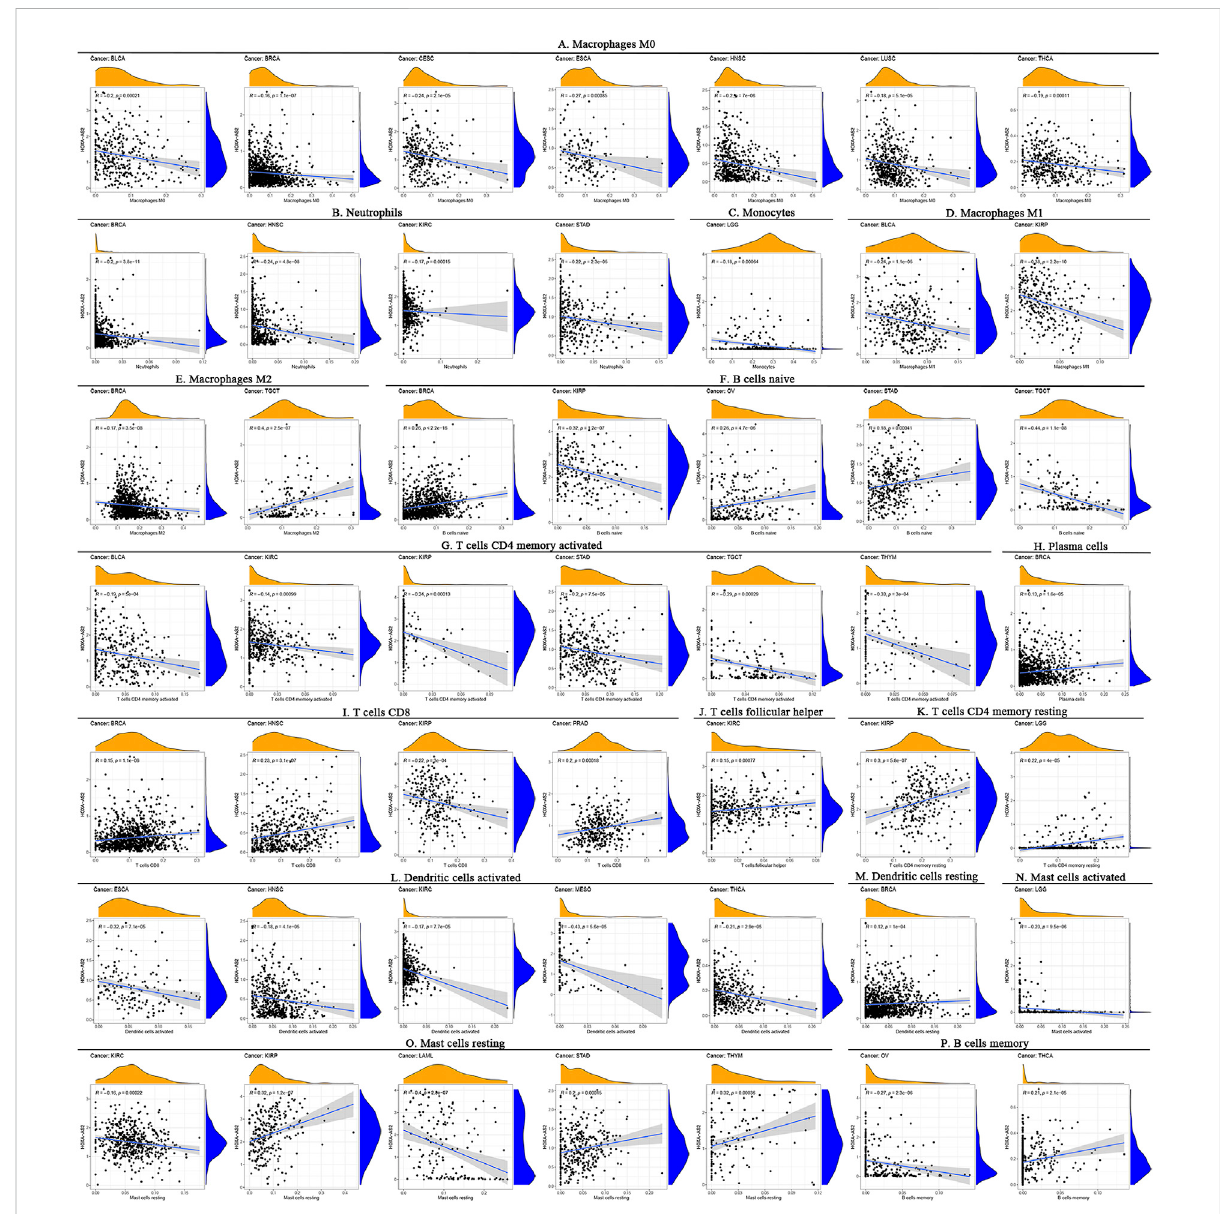
FIGURE 7 Correlation between HOXA-AS2 gene expression and the level of immune cell in fi ltration in pan-cancerous tissues. HOXA-AS2 expression signi fi cantly correlated with in fi ltrating levels of M0 macrophages in BLCA, BRCA, CESC, ESCA, NHSC, LUSC, and THCA (A) , neutrophils in BRCA, HNSC, KIRC, and STAD (B) , monocytes in LGG (C) , M1 macrophages in BLCA and KIRP (D) , M2 macrophages in BRCA and TGCT (E) , naive B cells in BRCA, KIRP, OV, STAD, and TGCT (F) , CD4 memory T cells in BLCA, KIRC, KIRP, STAD, TGCT, and THYM (G) , plasma cells in BRCA (H) , CD8 T cells in BRCA, HNSC, KIRP, and PRAD (I) , follicular helper Tcells in KIRC (J) , resting CD4 memory T cells in KIRP and LGG (K) , activated dendritic cells inESCA,HNSC,KIRC,MESO,andTHCA (L) ,restingDCsinBRCA (M) ,activatedmastcellsinLGG (N) ,restingmastcellsinKIRC,KIRP,LAML,STAD,and THYM (O) , memory B cells in OV and THCA (P)